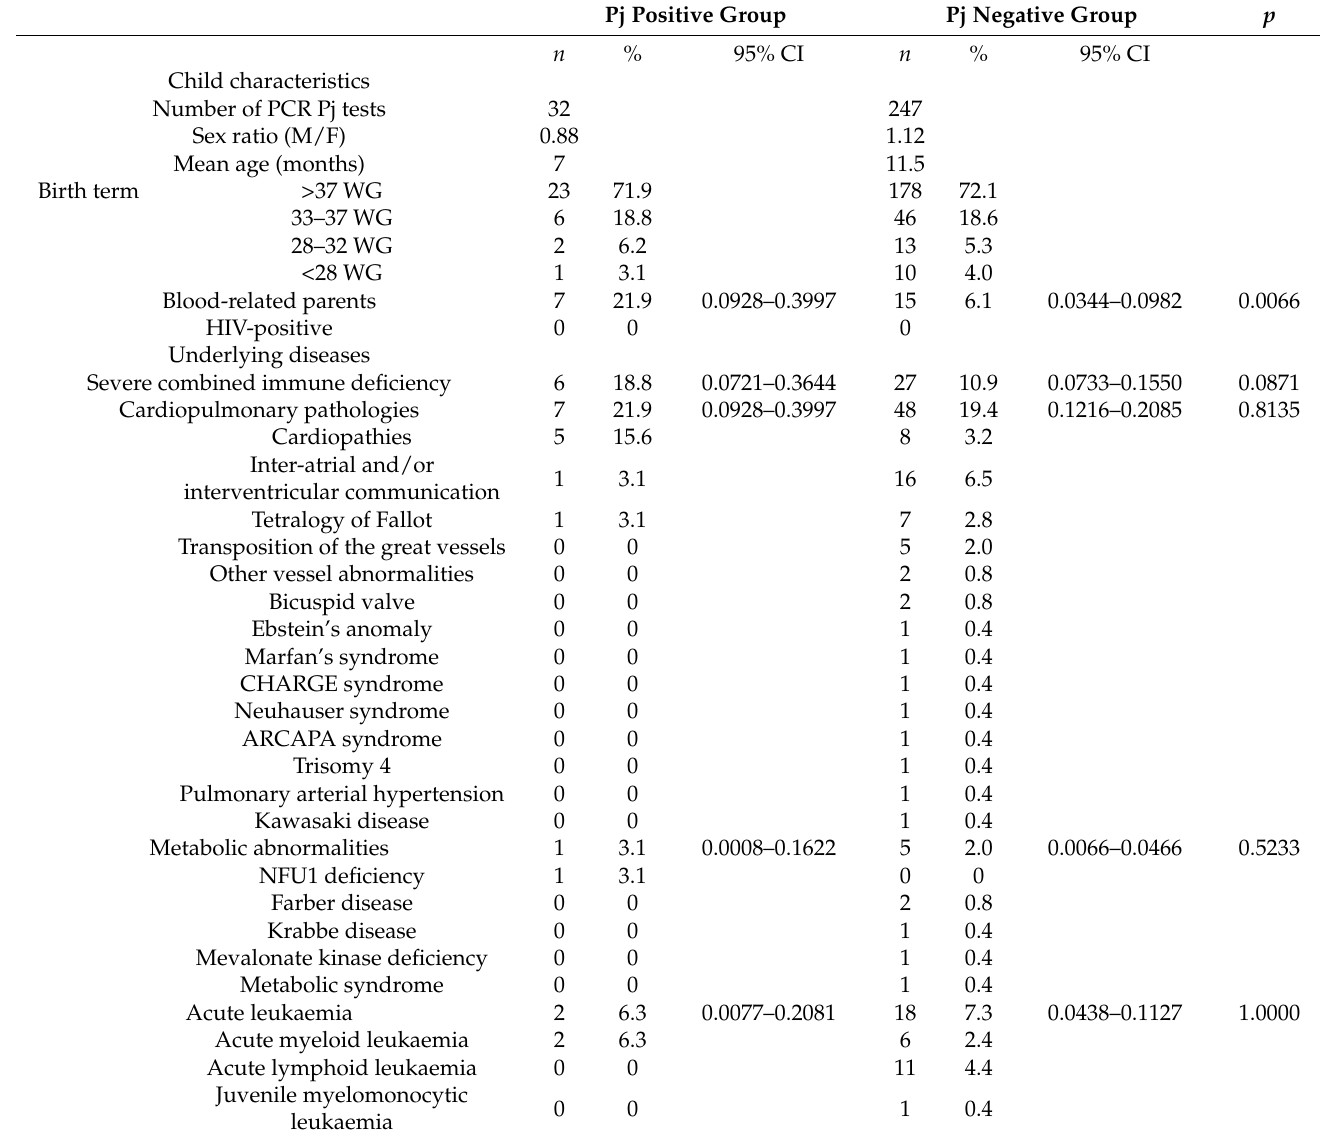
Table 1. Description of the child population